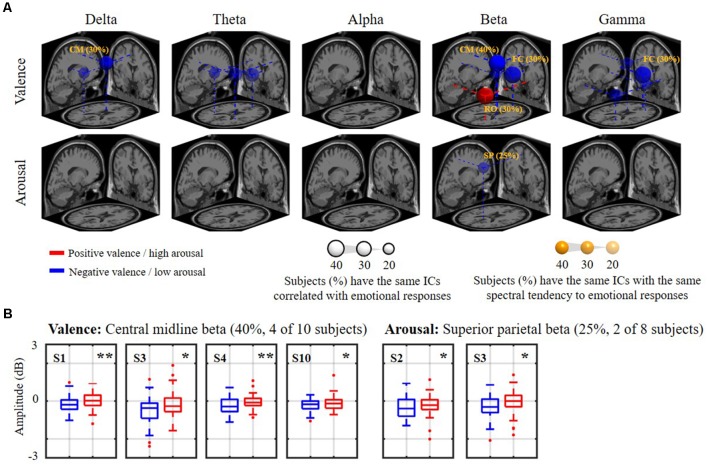
The relatively day-stationary, subject-common spatio-spectral oscillations in response to the binary valence and arousal states. Panel (A) refers to a 3D overview of emotion-relevant IC cluster centroids and their projections onto the MNI brain template (FC: frontal central, CM: central midline, RO: right occipital, SP: superior parietal). Sphere size was scaled to indicate the percentage of subjects with the same day-stationary IC significantly related to emotional responses (p < 0.05), and transparency further represents the percentage of subjects with the same spectral tendency towards an emotional label of the target ICs (annotated %). Only results above 20%, i.e., with at least two subjects in common, are shown. Red and blue colors represent the power suppression associated with positive valence/high arousal and negative valence/low arousal states, respectively. Panel (B) demonstrates valence and arousal outcomes with the highest inter-subject commonality. * and ** refer to a statistical significance of p < 0.05 and p < 0.01, respectively. Two subjects with highly imbalanced labels were excluded from the arousal analysis.